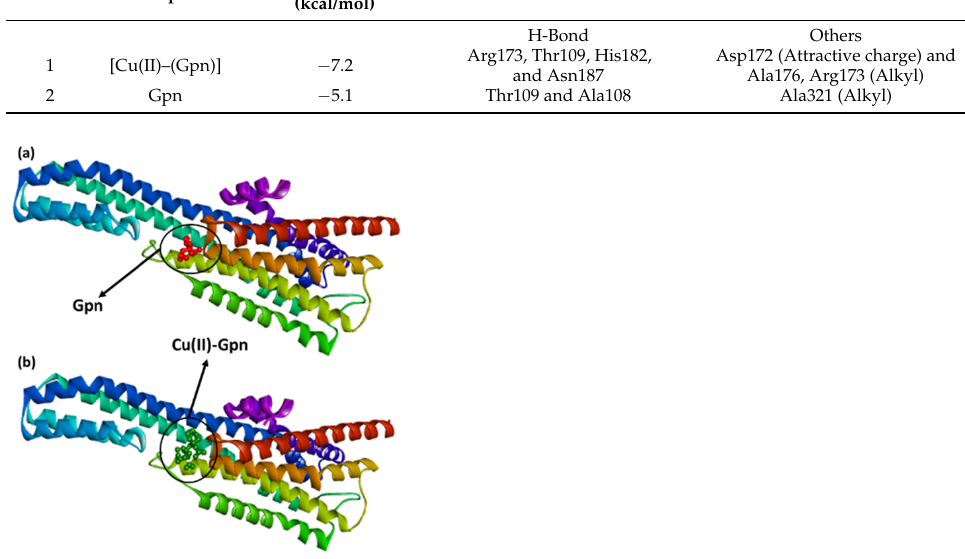
Figure 6. The best docked pose showing a helical model of serotonin (PDB ID: 6BQH) docked with ( a ) the Gpn drug and ( b ) metal complex [Cu(II)–(Gpn)]. An illustration of the molecular docking for the interactions of the ligands and receptor is depicted in Figure 7a,b.